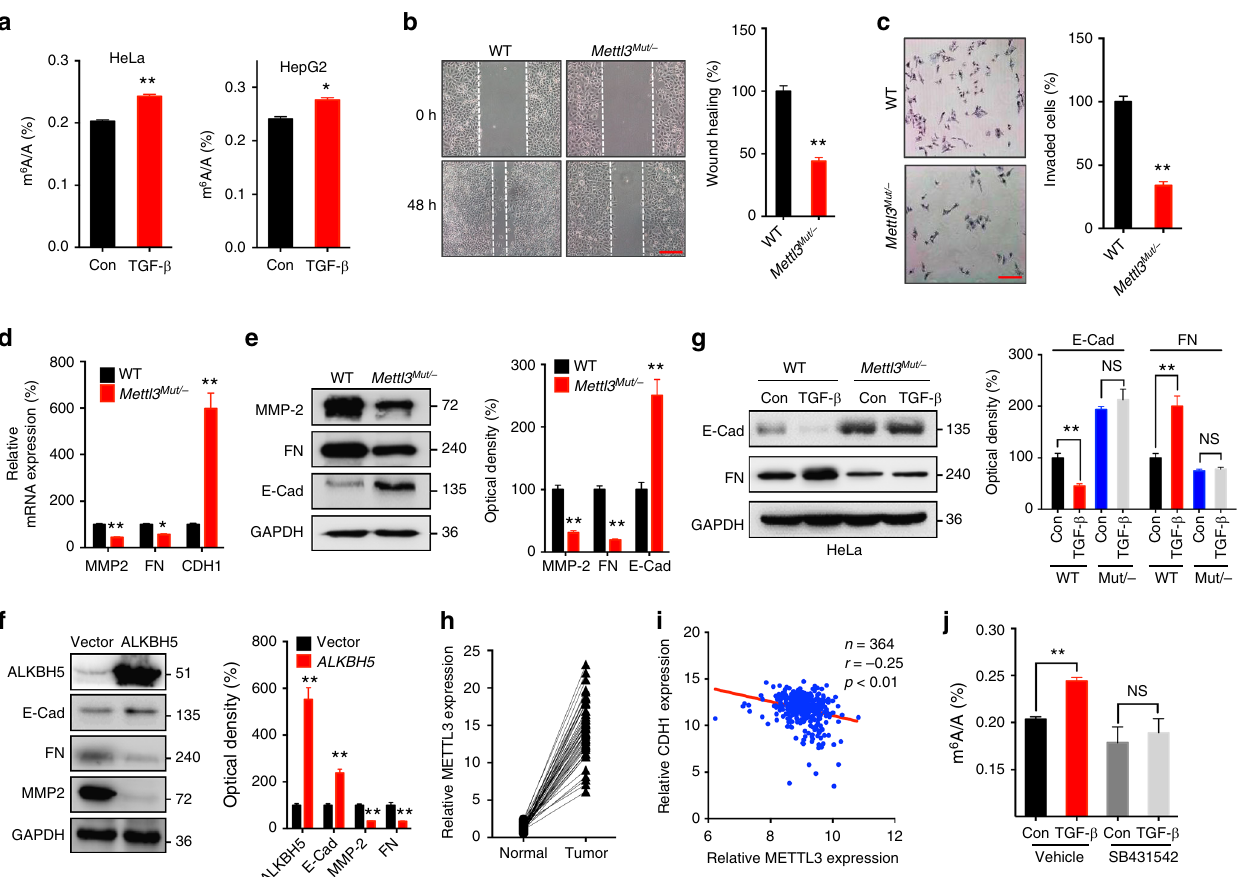
Fig. 1 EMT in cancer cells is regulated by m 6 A levels of mRNAs. a HeLa and HepG2 cells were treated with or without 10 ng/ml TGF- β for 3 days, the m 6 A/ A ratio of the total mRNA were determined by LC – MS/MS. b Wound healing of wild-type (control) or Mettl3 Mut/ − cells was recorded ( left ) and quantitatively analyzed ( right ). c Wild-type or Mettl3 Mut/ − cells were allowed to invade for 24 h and tested by CytoSelect ™ 24-well Cell Invasion assay kits (8 µ m, colorimetric format); d, e mRNA ( d ) and protein ( e ) expressions of MMP2, FN, and E-Cad in wild-type and Mettl3 Mut/ − HeLa cells were measured by qRT-PCR and western blot analysis, respectively. f HeLa cells were transfected with pcDNA/ALKBH5 or a vector control for 48 h, protein expression was determined by western blot analysis (left) and quantitatively analyzed (right). g Wild-type or Mettl3 Mut/ − cells were treated with or without 10 ng/ml TGF- β for 3 days, protein expression was determined by western blot analysis (left) and quantitatively analyzed (right). h The expression of METTL3 in liver cancer and its matched adjacent normal tissues of 50 patients from TCGA database. i Correlation between METTL3 and CDH1 in liver cancer patients ( n = 364) from TCGA database. j HeLa cells were pretreated with or without Smad2/3 inhibitor SB431542 (10 μ M) and then further treated with 10 ng/ml TGF- β for 3 days, the m 6 A/A ratio of the total mRNA were determined by LC – MS/MS. Data are presented as means ± SD from three independent experiments. * p < 0.05, ** p < 0.01, NS, no signi fi cant, by Student ’ s t test. Red bar = 200 μ (Fig. 2a). m 6 A peaks were especially abundant in the vicinity of start and stop codons (Fig. 2b). m 6 A-seq analysis identi fi ed 11,687 and 11,785 m 6 A peaks from 6836 to 7230 m 6 A-modi fi ed transcripts in control and EMT cells, respectively. In EMT cells, 4347 new m 6 A peaks and 4249 disappearing peaks were observed, while the remaining 7438 peaks were found in both control and EMT cells (Supplementary Fig. 3B). For m 6 A-regulated genes, m 6 A-seq identi fi ed 569 new modifying genes and 472 genes loss of m 6 A modi fi cation in EMT cells, while the other 2357 genes were found in both control and EMT cells (Supplementary Fig. 3C). The results indicated